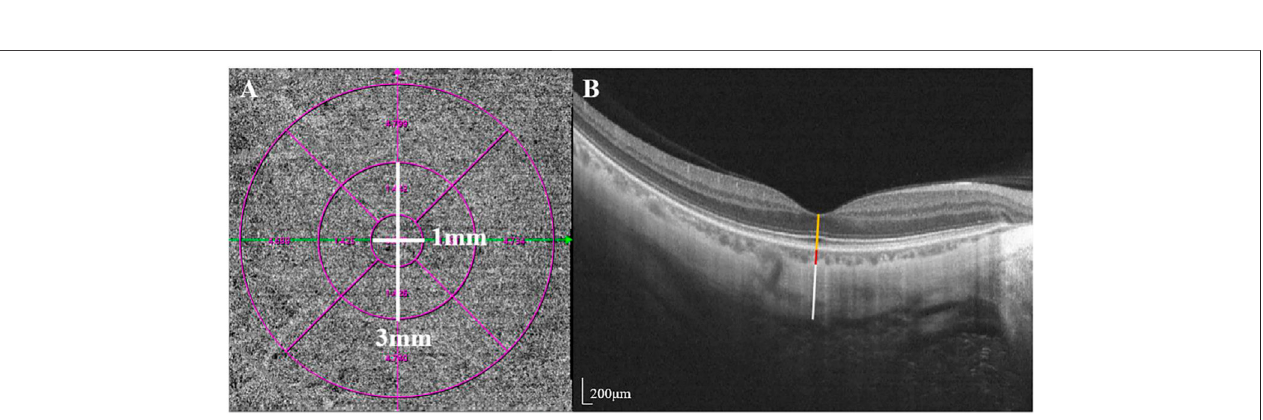
FIGURE 1 | Fundus photography, B-ultrasound and SS-OCT images of PS and NPS. (A – C) Right eye images of a 39-year-old male with PS, whose AL was 28.96 mm. (D – F) Right eye images of a 28-year-old male without PS, whose AL was 28.66 mm. The white arrow points to the edge of the PS. The thickness of the choroid was the thinnest at the edge of the staphyloma, being thickened gradually from the edge to the periphery and the posterior pole of the fundus.